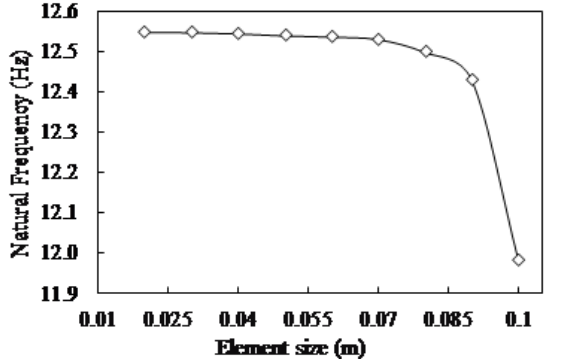
Figure 3: Mesh convergence in first bending mode